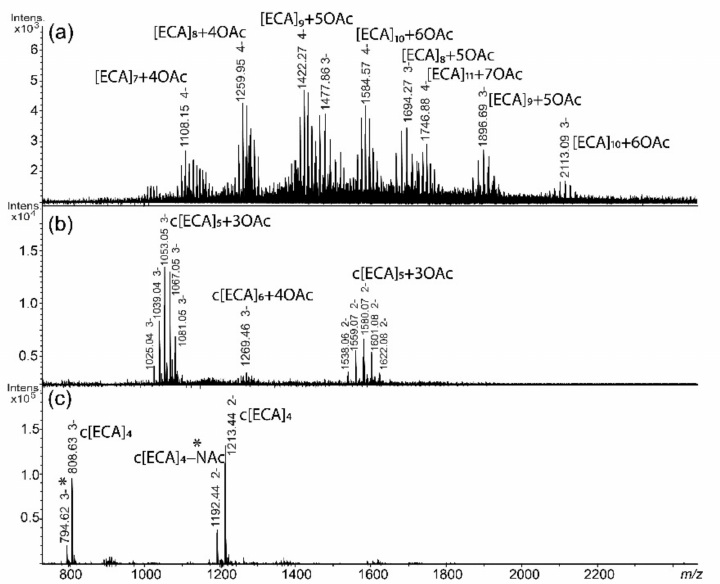
Figure 2. The ESI-MS spectra of the enterobacterial common antigen (ECA) forms obtained from